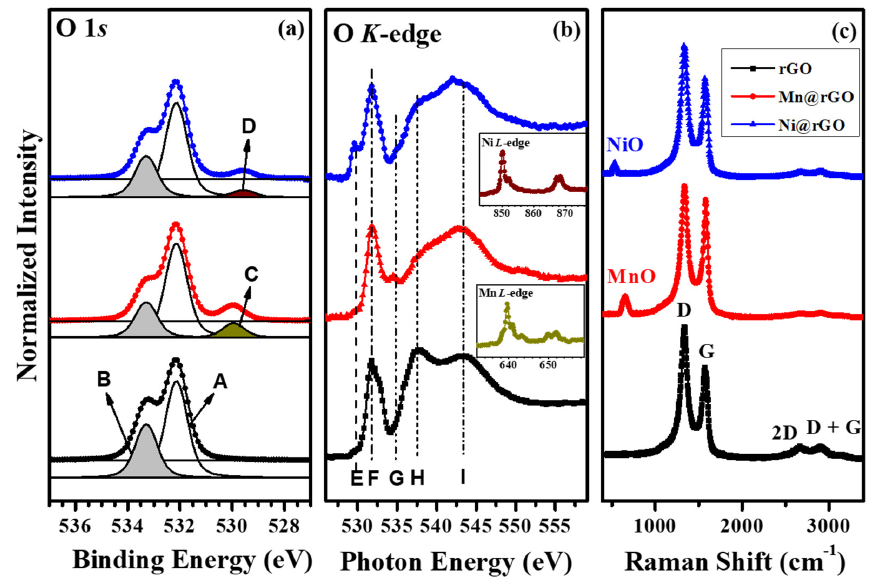
Figure 4. ( a ) HRPES, ( b ) XAS, and ( c ) Raman spectra of rGO (black), 5 wt% Mn@rGO (red), and 5 wt% Ni@rGO (blue); insets of ( b ) show Mn and Ni L-edge XAS spectra.